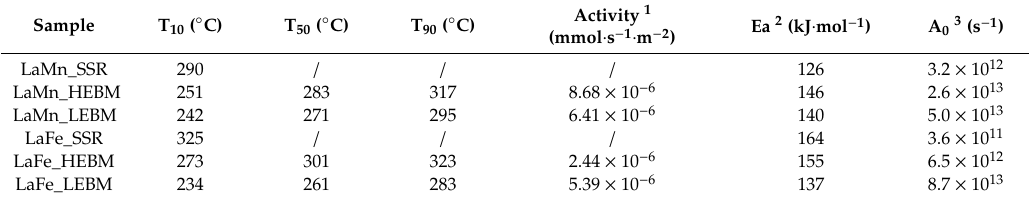
Table 4. T 50 values and kinetics data obtain from light-o ff curves of LaMn and LaFe samples.